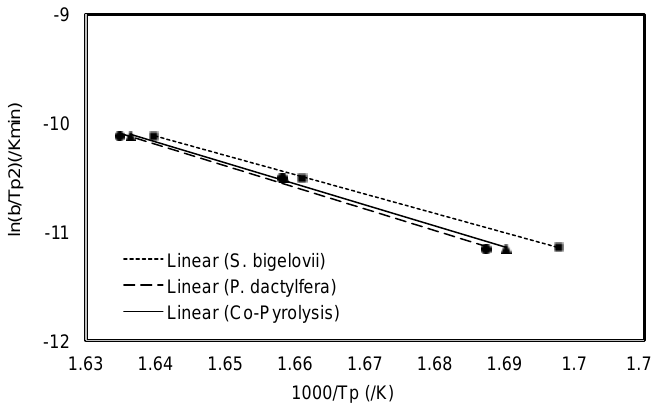
Figure 3. Kissinger curve for S. bigelovii , P. dactylifera and co-pyrolysis of them at a mass ratio of 1/1, at different isoconversional points.